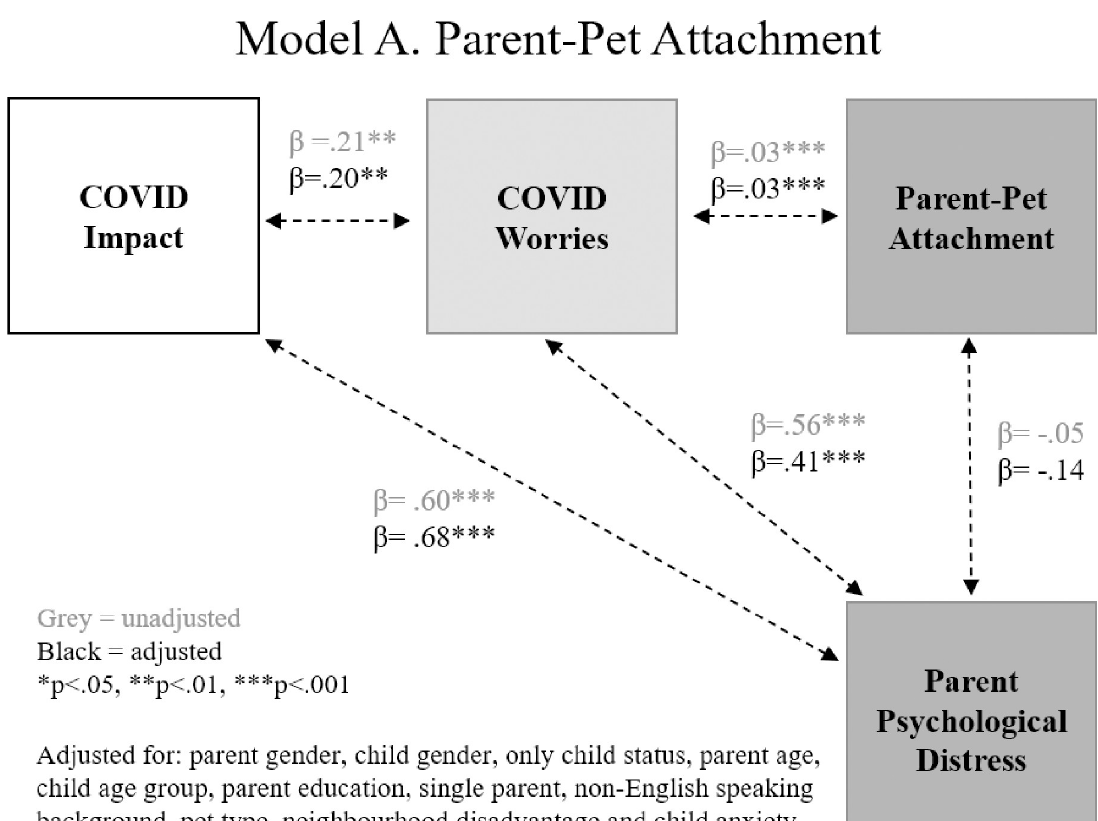
Fig 3. Model A: Associations between COVID-19 impact and worries, parent-pet attachment and parent mental health.